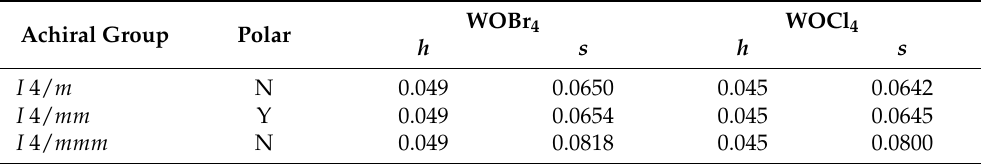
Table 7. Chirality of WO Z 4 compounds ( Z = Br, Cl). Given are the unnormalized Hausdorff distances, h , and continuous chirality measures, s , with respect to different possible achiral structures. WOBr 4 Achiral Group Polar